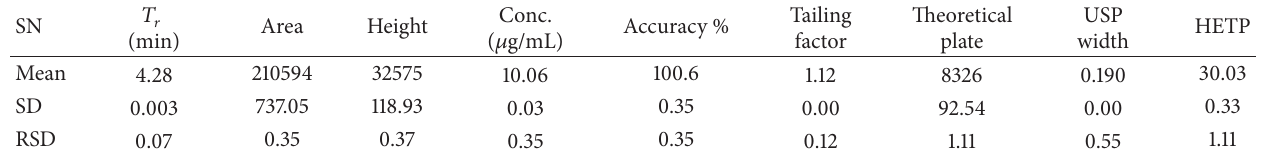
Table 4: System suitability parameters for trandolapril.